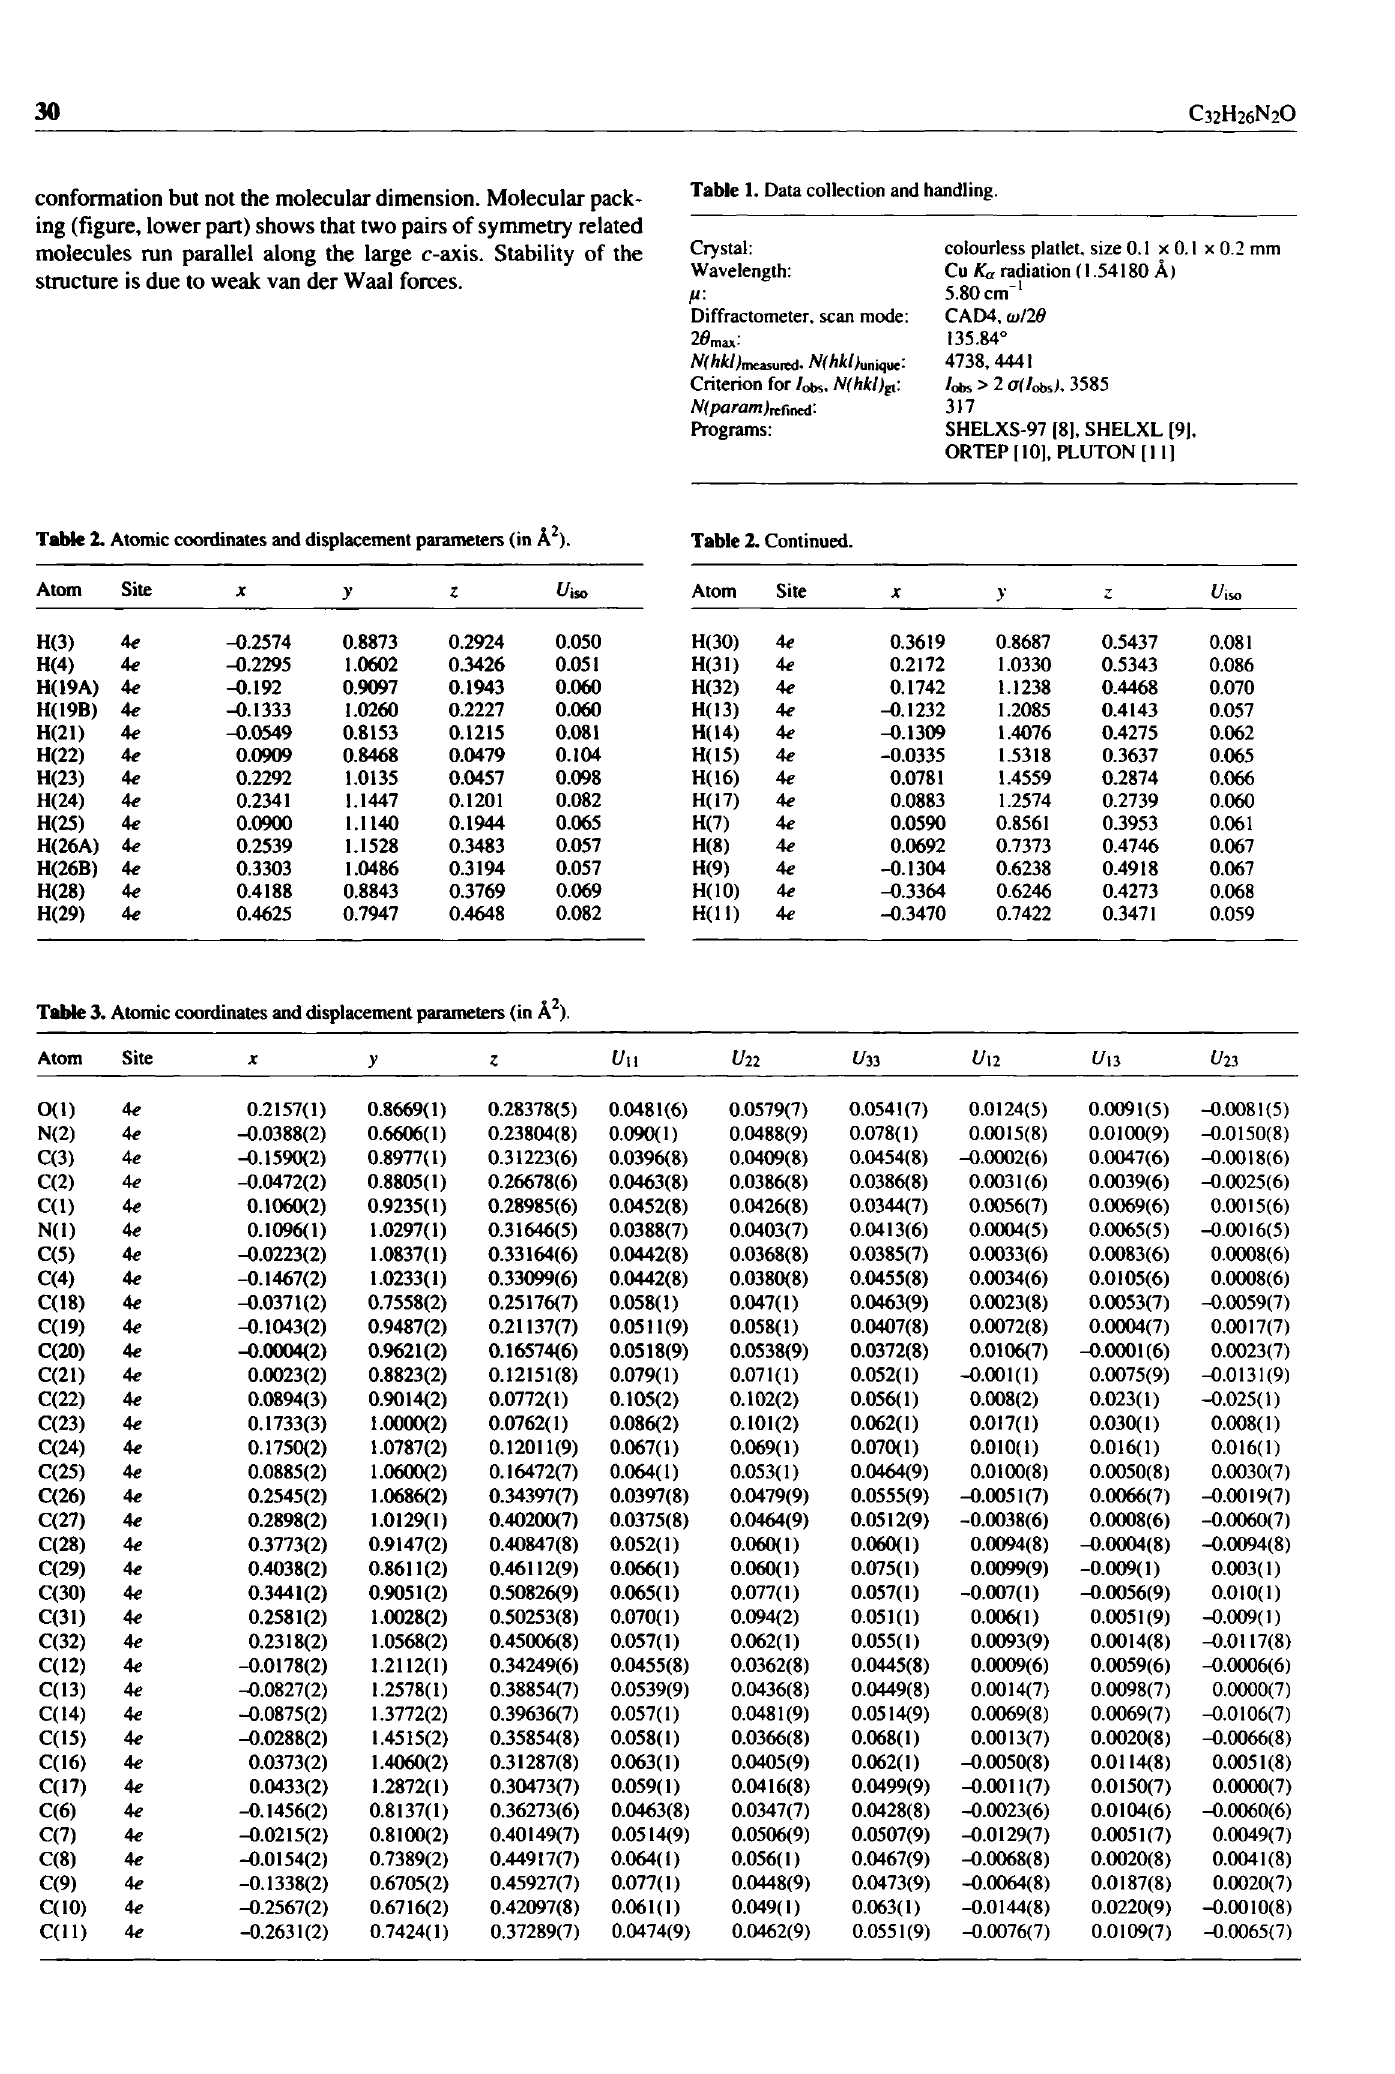
Table 2. Atomic coordinates and displacement parameters (in À 2 ). Table 2. Continued.